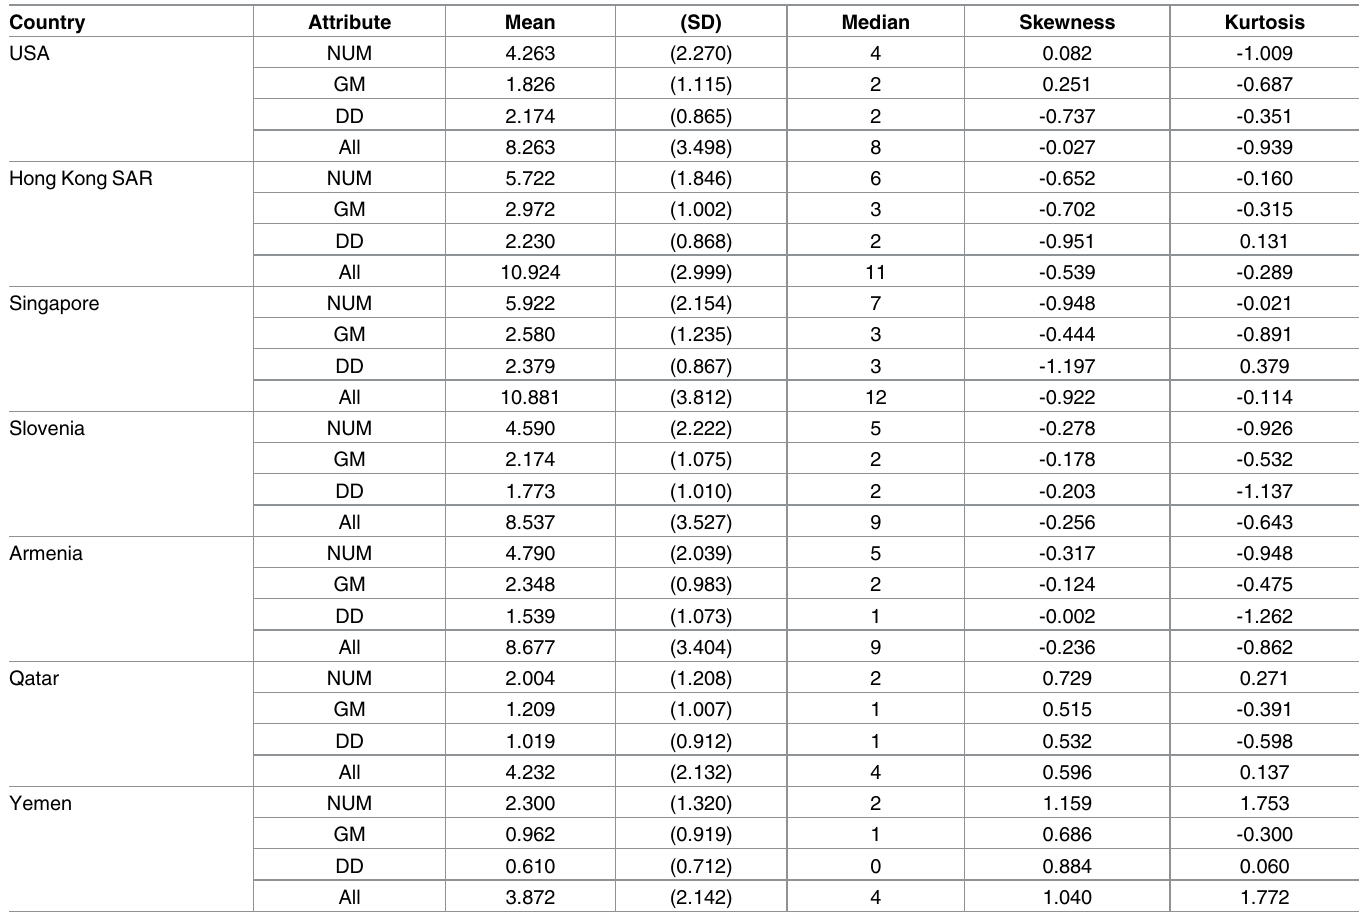
Table 6. Summarystatistics of the number of mastered attributes.